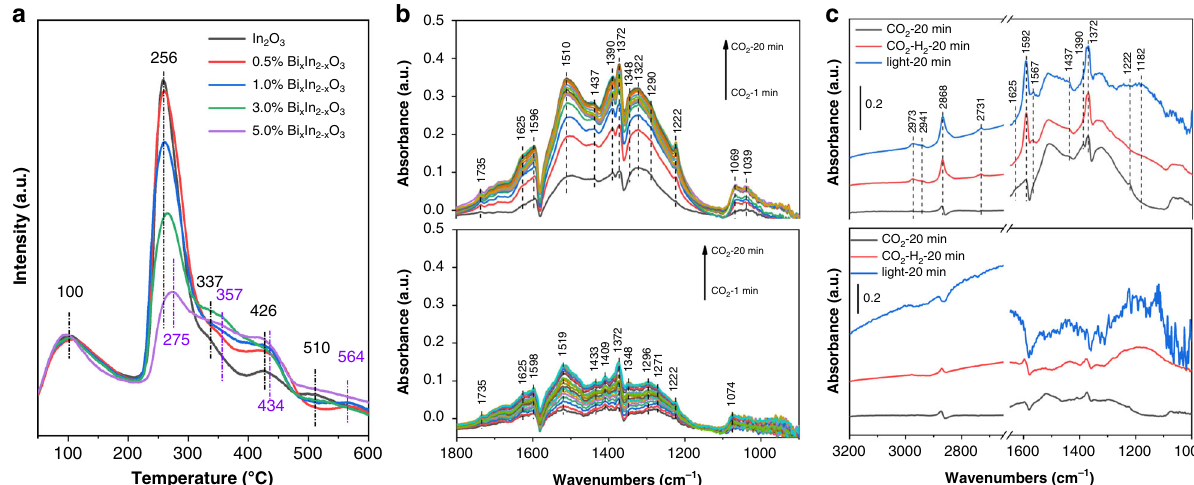
Fig. 5 In situ DRIFTS experiments of CO 2 adsorption and CO 2 hydrogenation. a CO 2 -TPD pro fi les. b In situ DRIFTS spectra for the adsorption of CO 2 on 1.0% Bi x In 2 – x O 3 nanocrystals (up) and pure In 2 O 3 (down). c In situ DRIFTS spectra of surface species under reaction conditions on 1.0% Bi x In 2 – x O 3 nanocrystals (up) and pure In